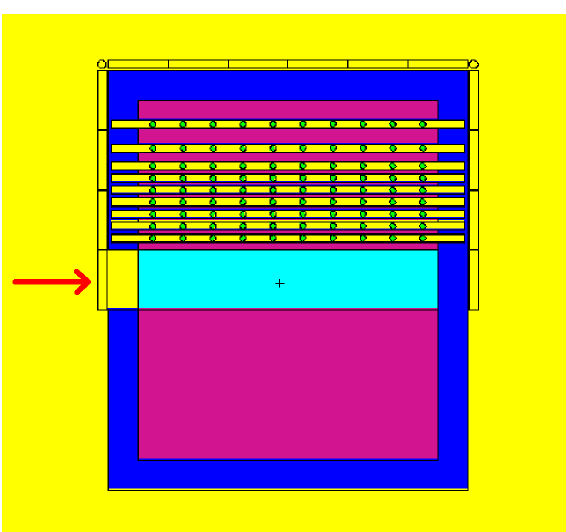
Figure 5. B-URAN sectional view, bismuth target, red arrow is a symbol of proton beam (created by